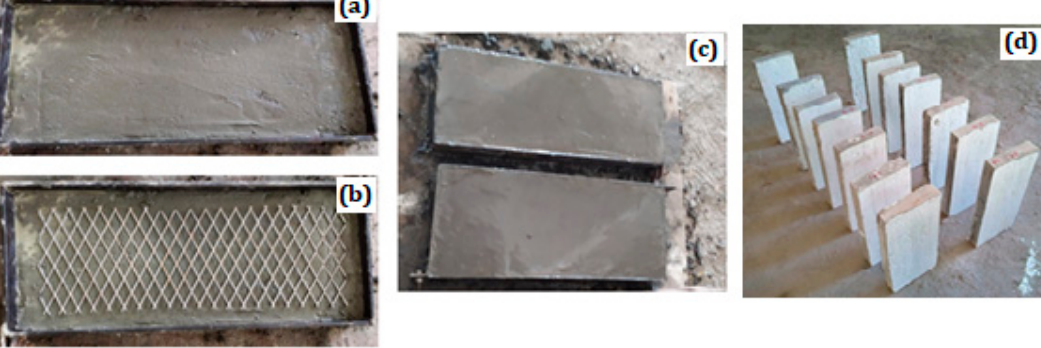
Figure 3. Process of casting ferrocement panel ( a ) finished layer before mesh placement; ( b ) mesh arrangement; ( c ) finished ferrocement panel; and ( d ) ferrocement panel before testing.